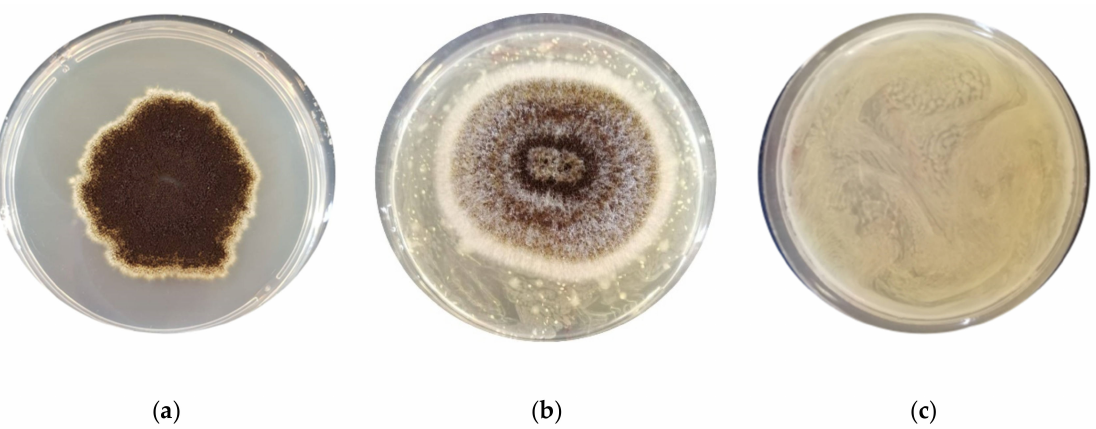
Figure 2. Aspergillus niger on control plate ( a ) and on plate inoculated with Leuconostoc citreum UMCC 2993 ( b ) and UMCC 3011 ( c ).